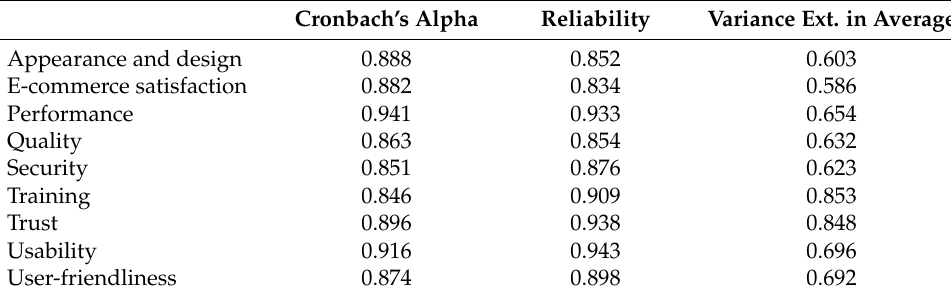
Table 3. Summarized statistics of reliability.